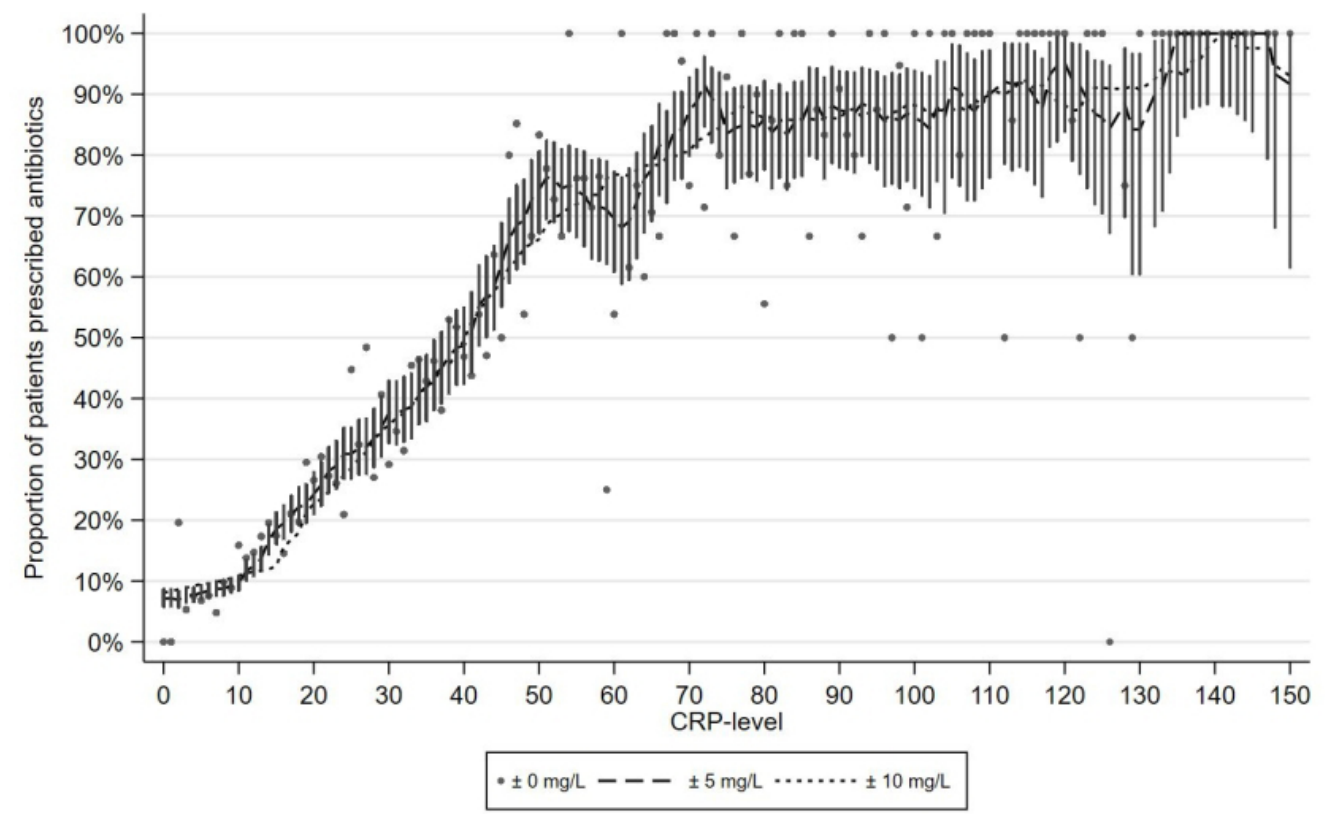
Figure 1 C- reactive protein (CRP) levels and the proportion of patients prescribed an antibiotic . Legends indicate the width of the interval around the index CRP level used to calculate the proportion of patients who were prescribed antibiotics, respectively 0, 5, and 10mg/L above and below. Bars indicate 95% confidence intervals. CRP levels 150–300mg/L not shown.